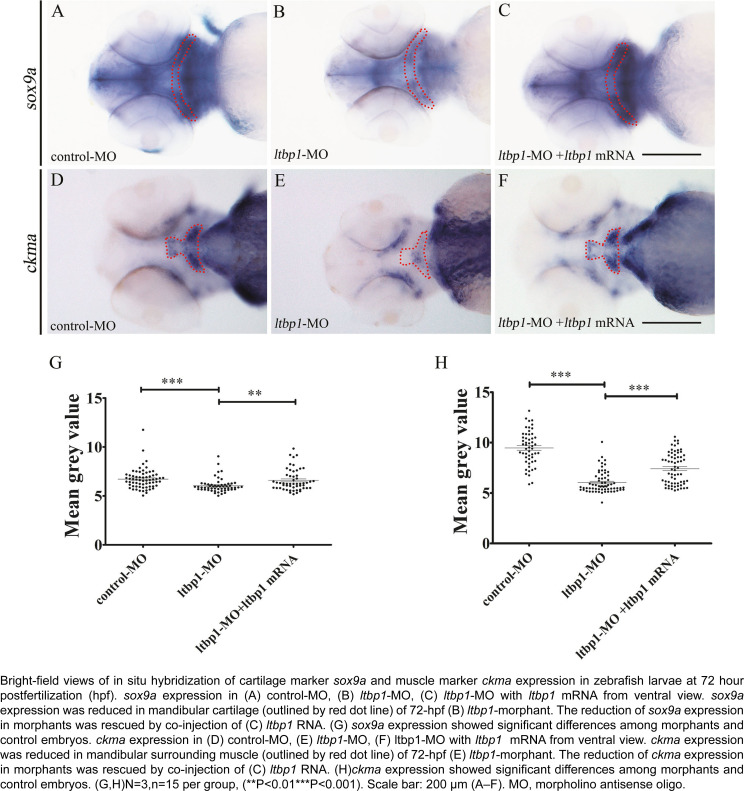
Loss of ltbp1 function affects formation of both craniofacial cartilage and muscle